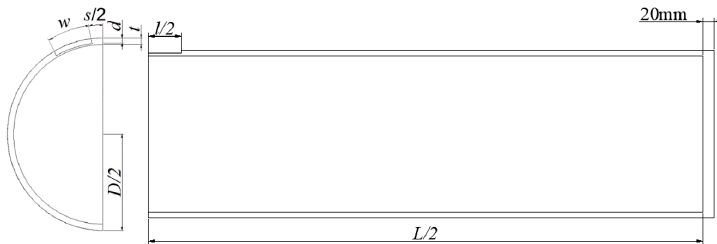
Figure 3. Quarter pipe model of a pipe with circumferentially aligned interacting corrosion defects.